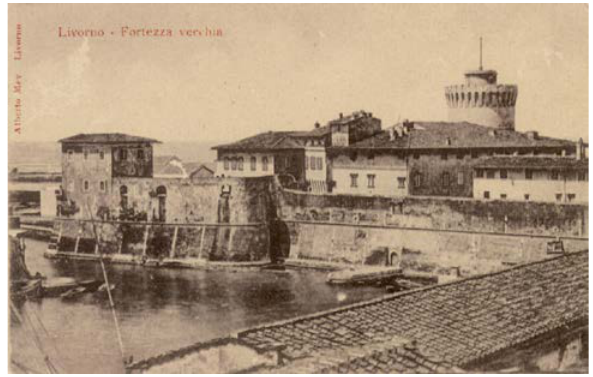
Figure 7: Archive image of the South side of Palazzo di Cosimo ( Collezione Pelosini , Courtesy Biblioteca Labronica F.D. Guerrazzi - Livorno)